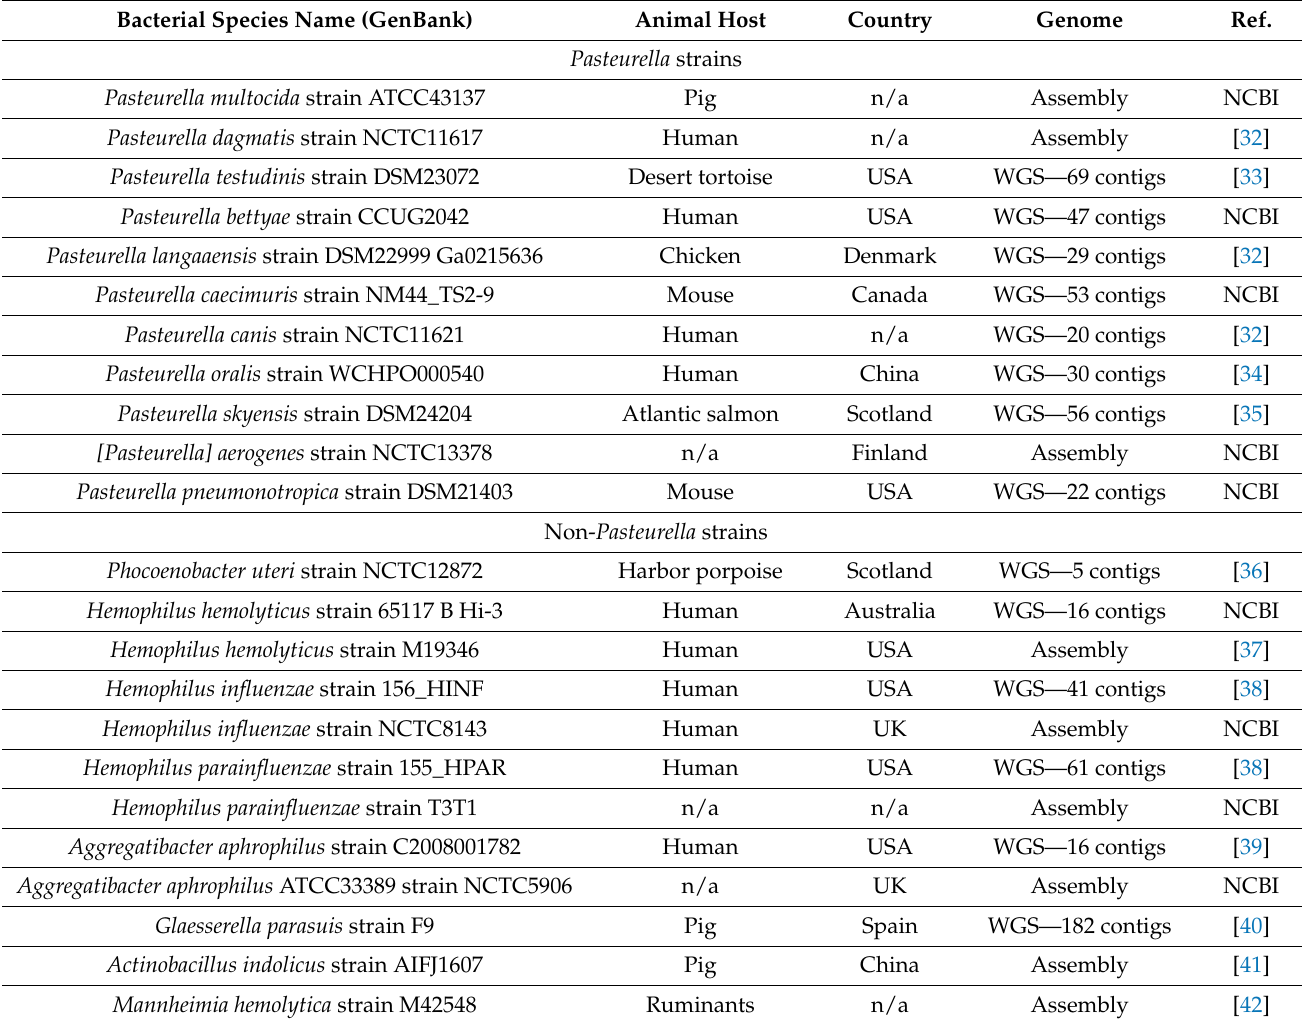
Table 1. Twenty-three Pasteurellaceae genomes used to evaluate the phylogenetic position of P. atlantica . Bacterial Species Name